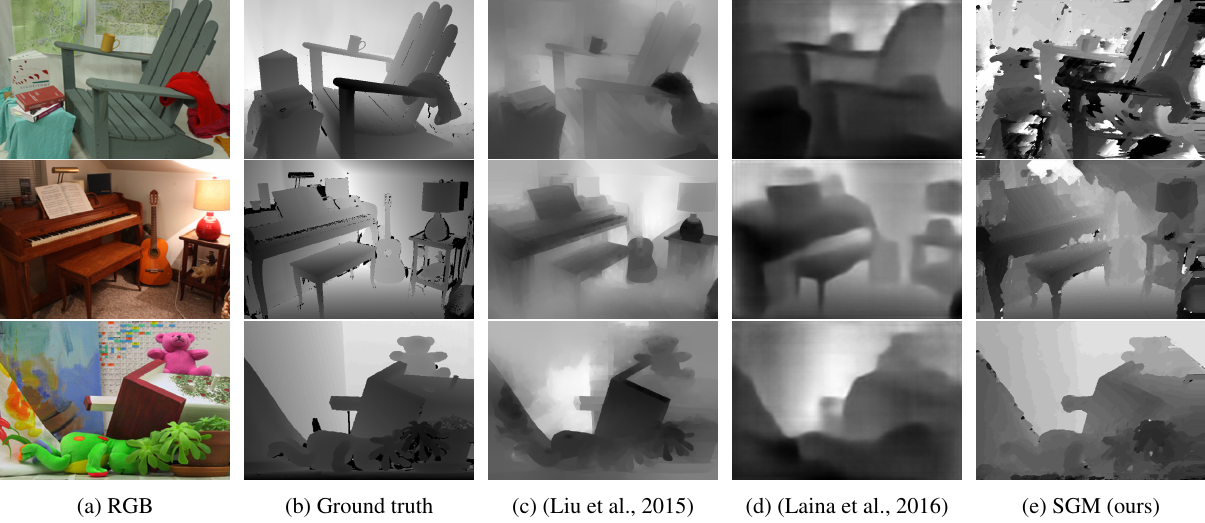
Figure 1. Samples (rows) from the Middlebury dataset comparing ground-truth depth maps (b), SIDE predictions (c+d), and SGM depth maps (e)